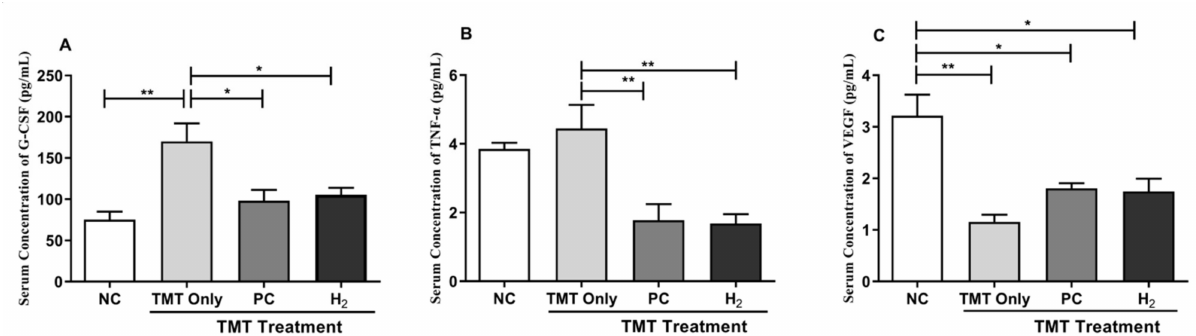
Figure 7. Effects of H 2 gas inhalation treatment on inflammatory cytokines and VEGF in serum in TMT-induced C57BL/6 mice after four weeks. ( A ) G-CSF, ( B ) TNF- α , ( C ) VEGF. Data are shown as the mean ± SEM for n = 4 mice. Significant differences were analyzed with ANOVA and Tukey’s test. * p < 0.05, ** p < 0.01.